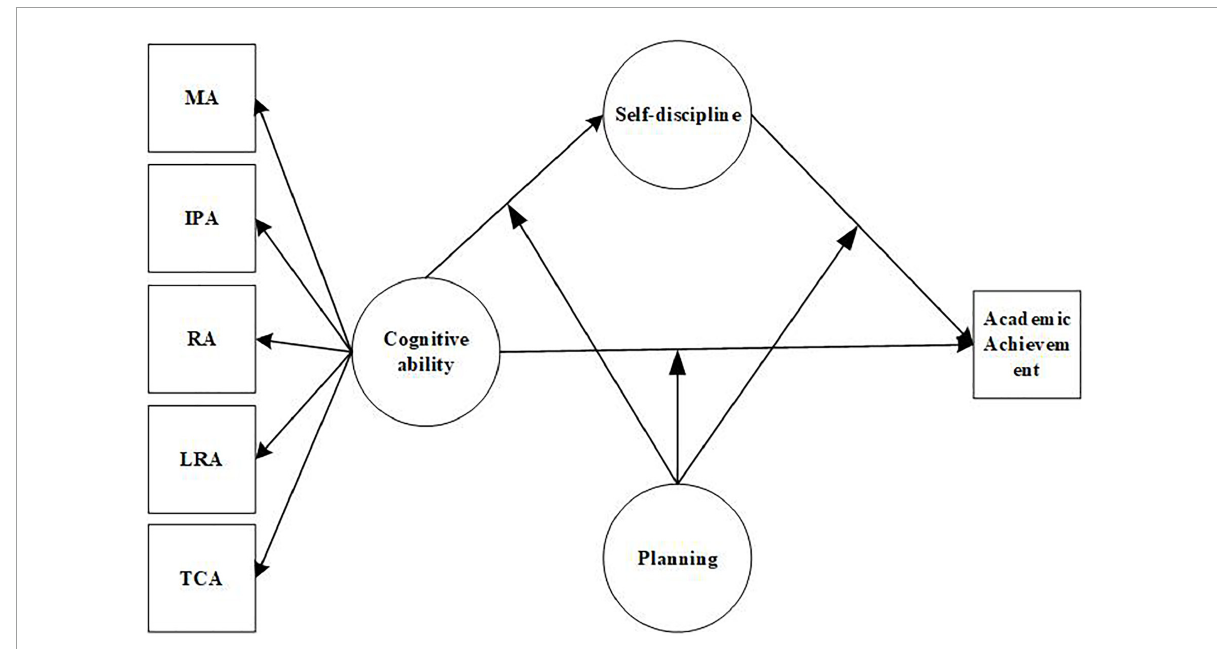
FIGURE1 Structural equation relationship diagram. MA, Memory ability; IPA, Information processing ability; RA, Representation ability; LRA, Logical reasoning ability; TCA, Thinking conversion